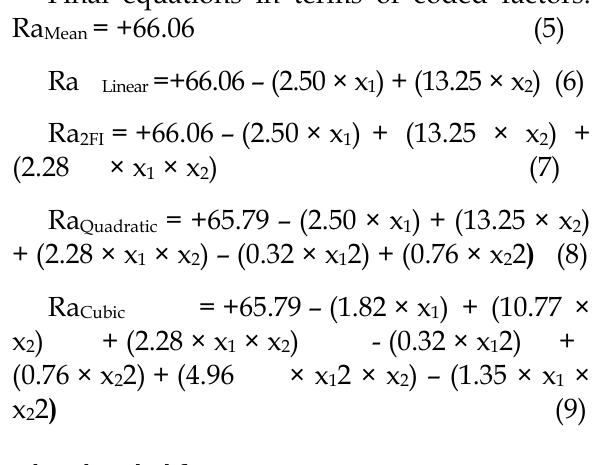
Table 1. The central composite design (CCD) using natural and coded factors